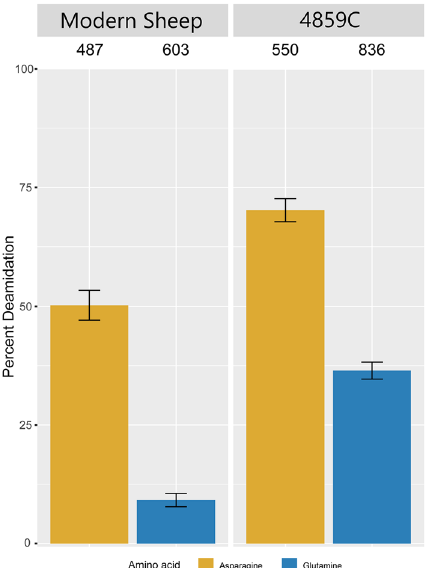
Figure 5. Deamidation levels of modern sheep sample G and Spoegrivier sheep P4859C: Overall percentage of deamidation for asparagine (N) and glutamine (Q) residues for tryptic peptides from archaeological sample P4859C compared with modern sheep bone G, excluding contaminants. Error bars represent standard deviations and the numbers above each bar represent the numbers of peptides on which the calculations are